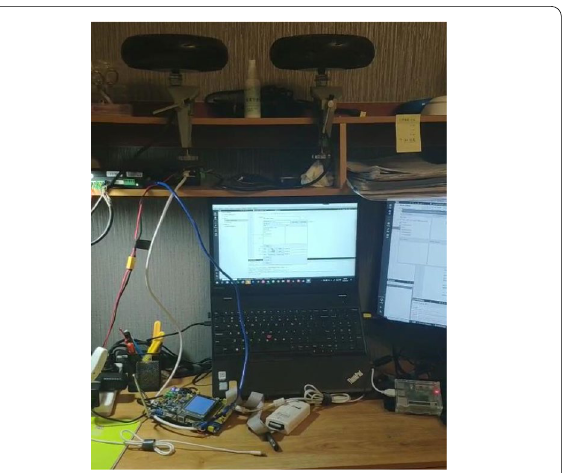
Figure 11 Sensor accuracy experiment platform